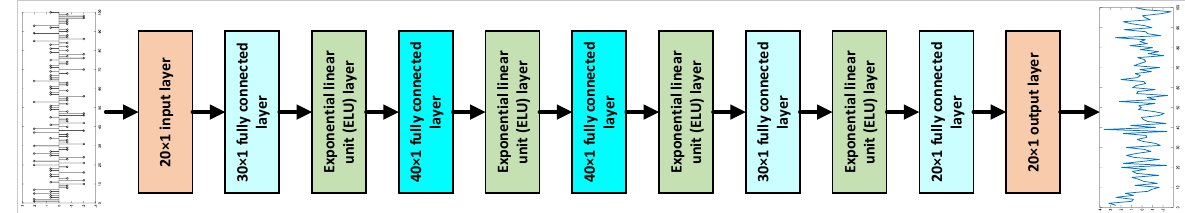
Figure 3. The model architecture for the signal reconstruction using low-bit ADC.